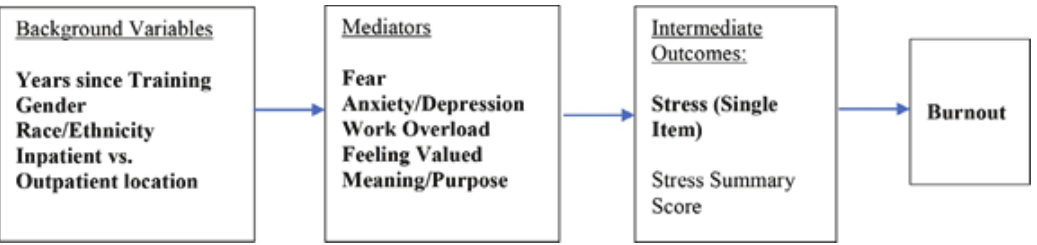
Figure 1 : Potential contributors and mitigators of stress and burnout